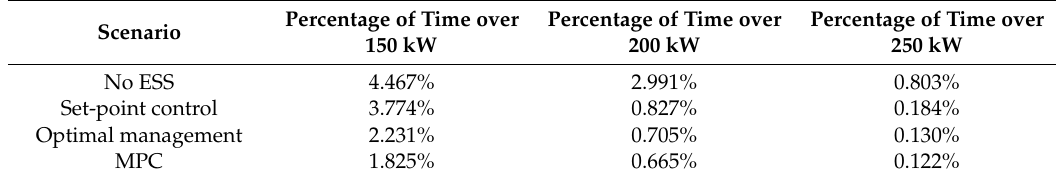
Table 4. Parameters of the Energy Storage System (ESS).